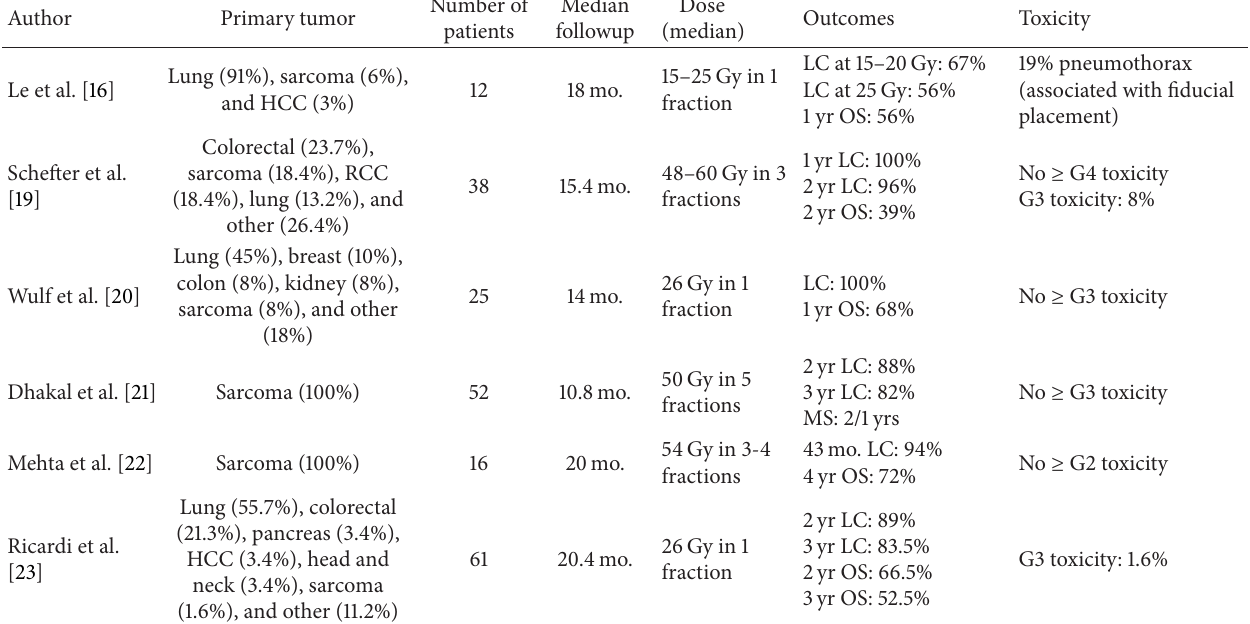
Figure 1: Axial view (a) and coronal view (b) of isodose distributions and beam arrangements (c) for SBRT of a right upper lobe metastasis. Table 1: Summary of SBRT studies.